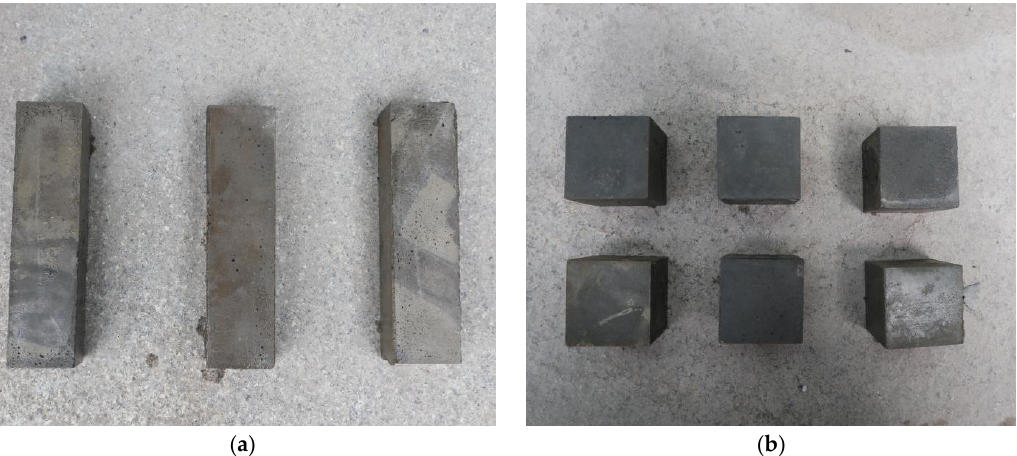
Figure 1. Formed sample: ( a ) mortar sample; ( b ) paste sample. After the sample is prepared, it is placed in the standard curing room with a temper- ature of (20 ± 2) °C and relative humidity of 95% for 7 days, and then moved to a room with a temperature of (20 ± 2) °C until it is cured for 28 days. Table 3 shows the sample mix proportion.